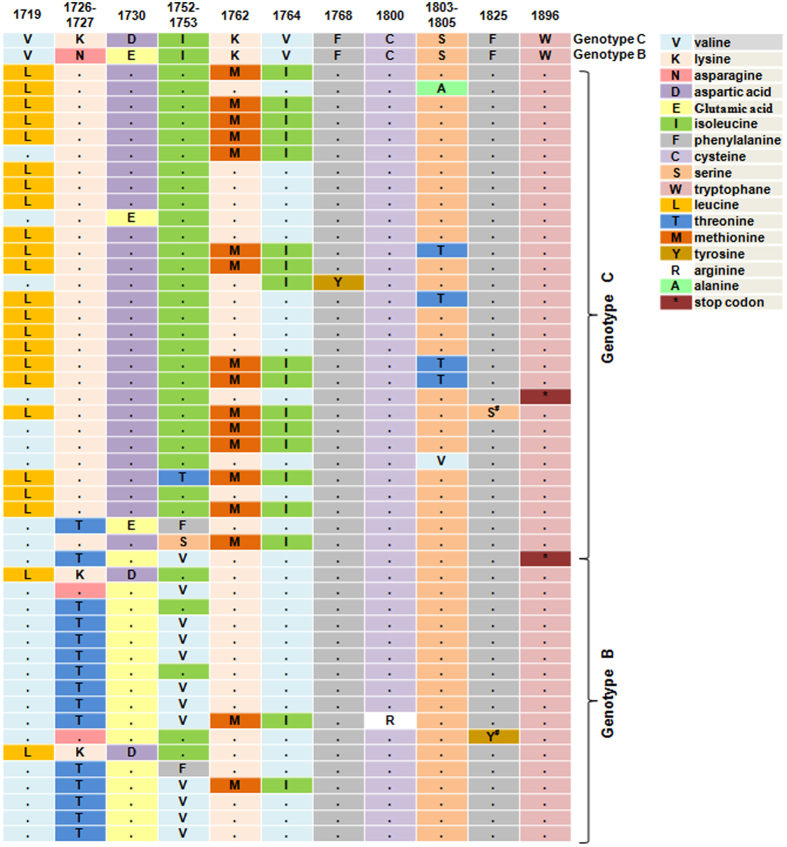
Amino acid transitions induced by mutations in the EnhII/BCP/PC regions.S*: T1825C affects codon 151 of the X gene (F151S); Y*: T1825A affects codon 151 of the X gene (F151Y) and codon 4 of the PC gene (F4L).